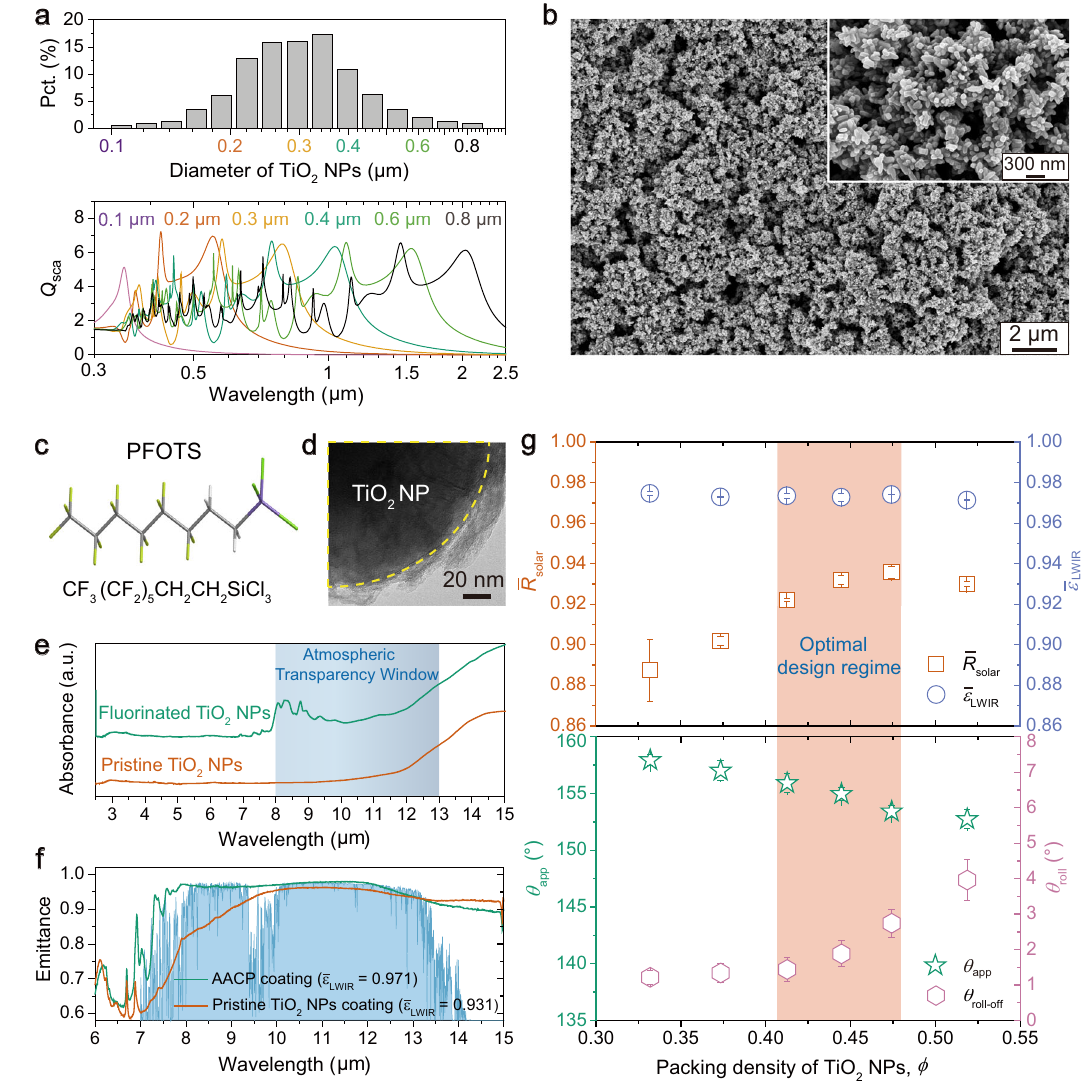
Fig. 2 | The optical and wetting properties of AACP. a TiO 2 NPs size distribution (characterizedbydynamiclightscattering)and thecalculatedscattering ef fi ciency ( Q sca ) as a function of particle size and incident light wavelength. The strong scatteringpeaksfromparticleswithvarioussizescoverthewholesolarspectrumin favor of high solar re fl ectance ( R ̅ solar ). b Scanning electron microscopy image showing the AACP coating surface composed of TiO 2 NPs forming micro/nano- roughness. c A wireframe showing the structure of PFOTS. d TEM image showing